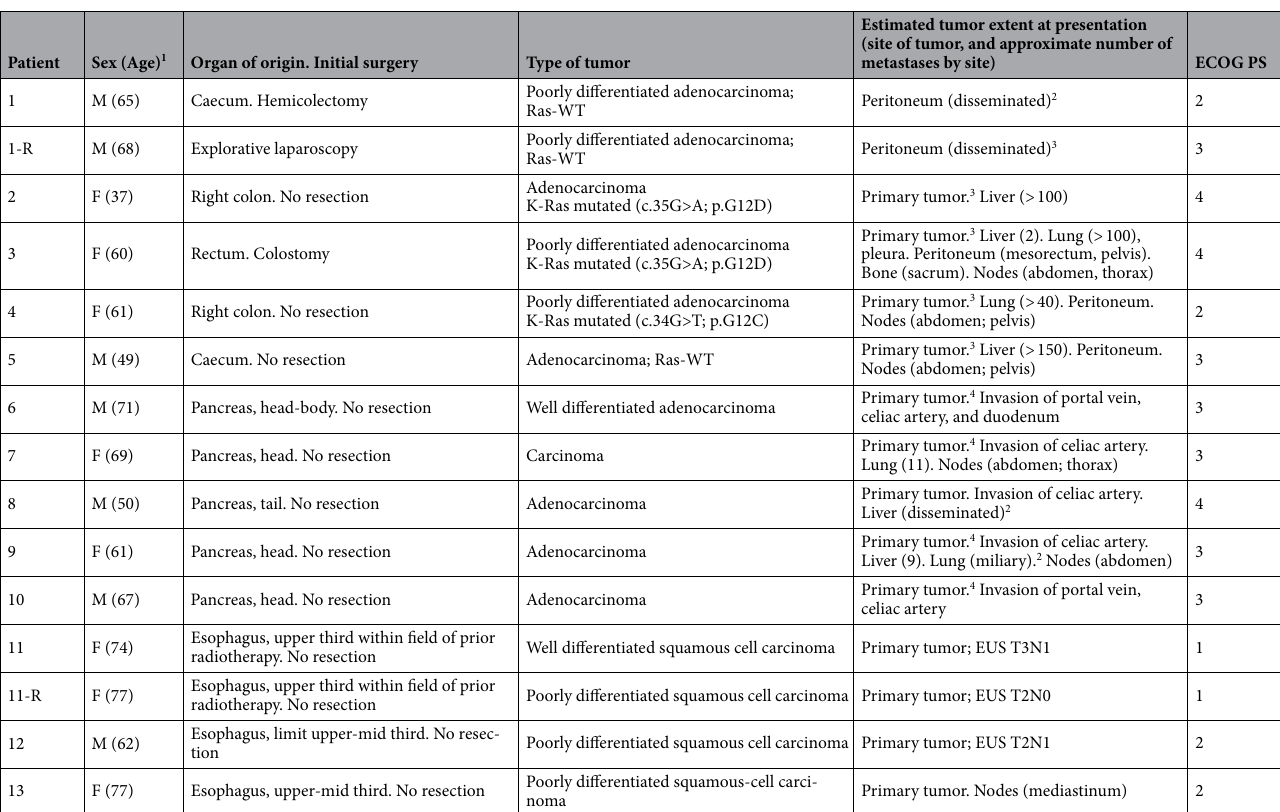
Table 1. Characteristics of patients treated with regimens including 5-fluorouracil, folinic acid, and pyridoxine in tandem. 1 Age at start of treatment with FUra, FA and B6 in tandem. 2 Presence of countless tumor foci. 3 Patient with partial bowel obstruction. 4 Patient with obstructive cholestasis. EUS, endoscopic ultrasonography. R,